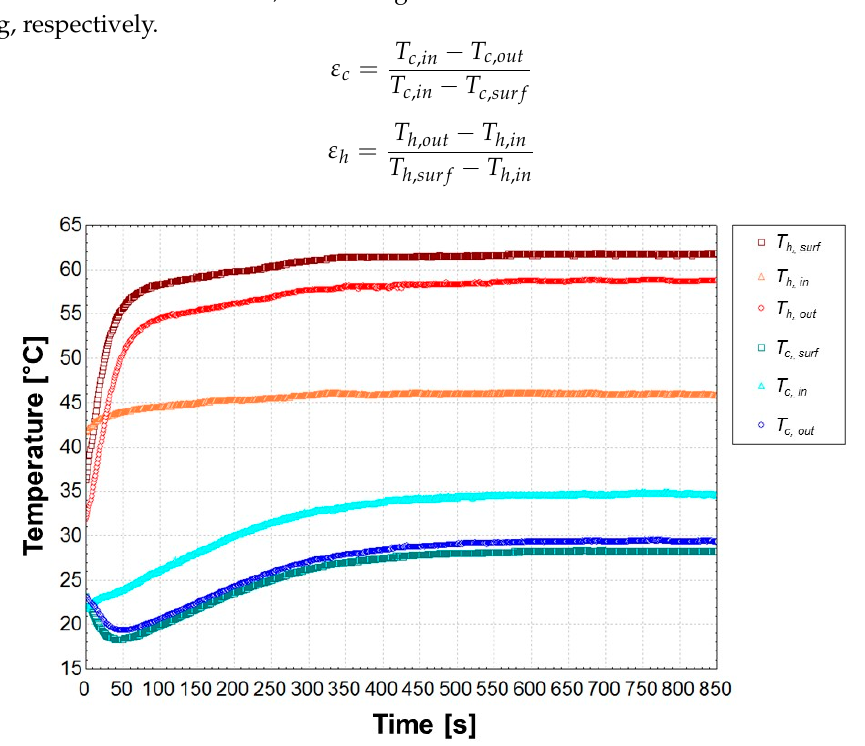
Figure 3. Performance of thermoelectric heat pump in Case 9.